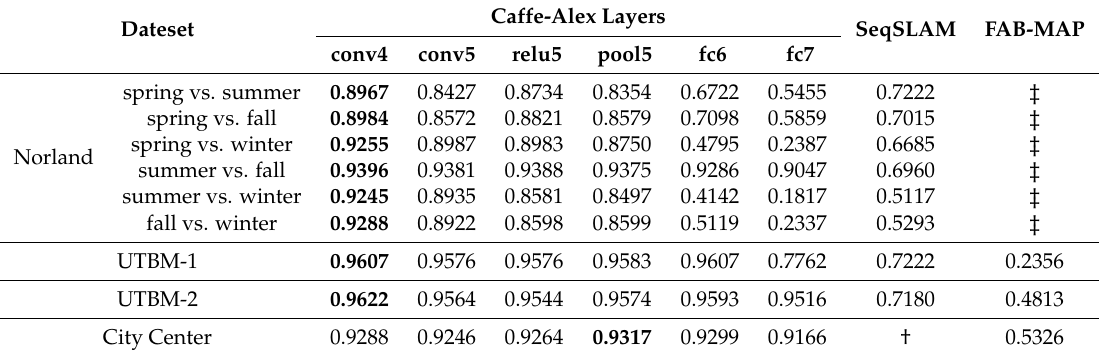
Table 3. F 1 -Scores considering different Caffe-AlexNet layers and other state-of-the-art methods (SeqSLAM and FAB-MAP). The † means the F 1 score is smaller than 0.01, and ‡ means experiment fails. For each data set, the highest F 1 -Score is